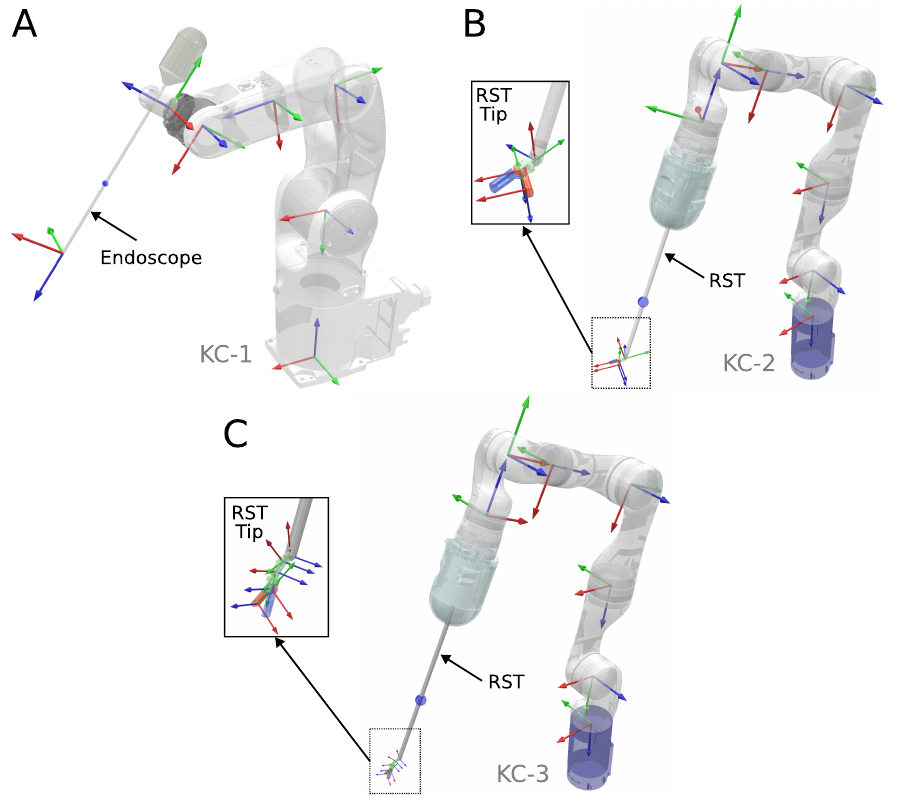
Figure 2. Three kinematic chains were used for numerical validation in simulation. ( A ) A 6-DOF endoscope holder. ( B ) A 7-DOF manipulator holding a 3-DOF robotic surgical tool. ( C ) A 7-DOF manipulator holding a 5-DOF robotic surgical